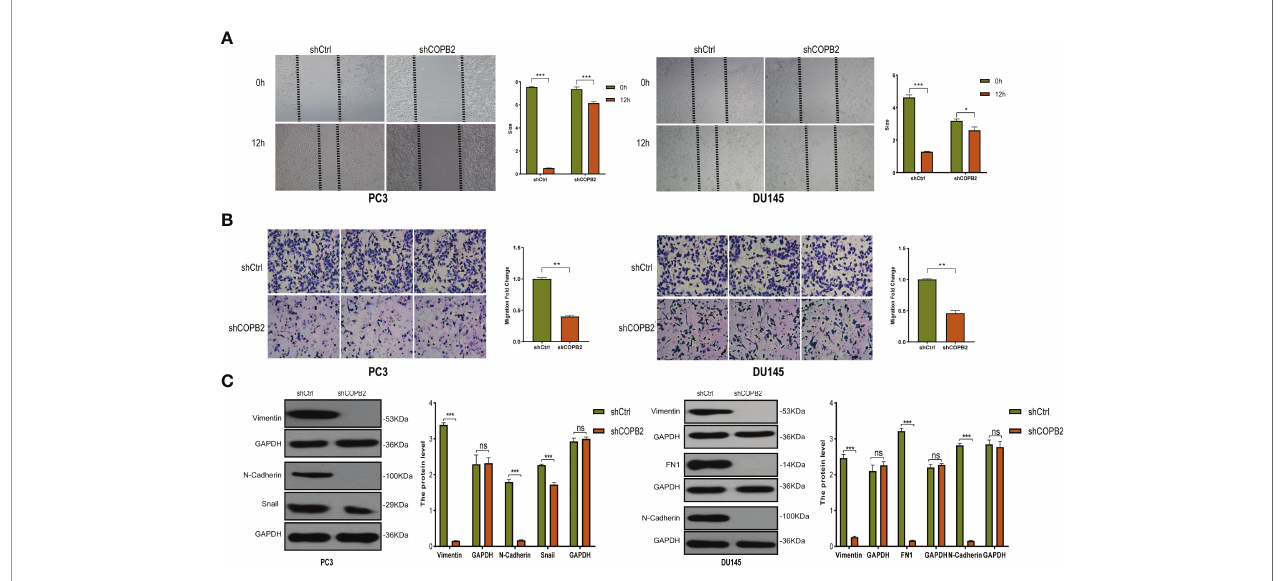
FIGURE 3 | COPB2 knockdown inhibited migration and invasion in PC-3 and DU-145 cell lines. (A) A wound healing assay was performed to study the migration of COPB2 knockdown on PC-3 and DU-145 cell. (B) A Transwell assay was performed to study the invasion of COPB2 knockdown on PC-3 and DU-145 cell. (C) Motility inhibition by COPB2 knockdown was associated with EMT suppression in PC-3 and DU-145 cells. EMT markers (Vimentin, N-Cadherin, Snail, and FN1) were assessed by western blot. * P < 0.05, ** P < 0.01, *** P < 0.001, ns, not signi fi